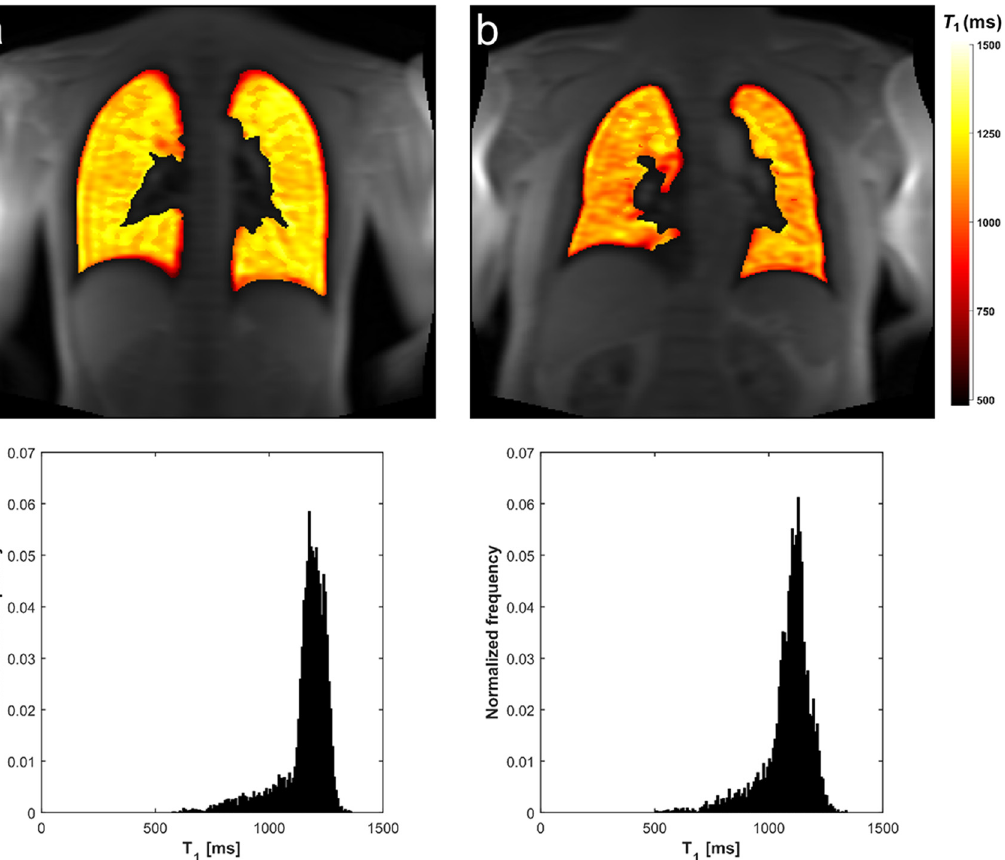
Fig 1. Lung T 1 maps in a young and old never smoker. Representative coronal lung MRI T 1 maps overlaid on a signal intensity image with corresponding normalized T 1 histograms for a 25 years old (a) and a 60 years old (b) never smoker.